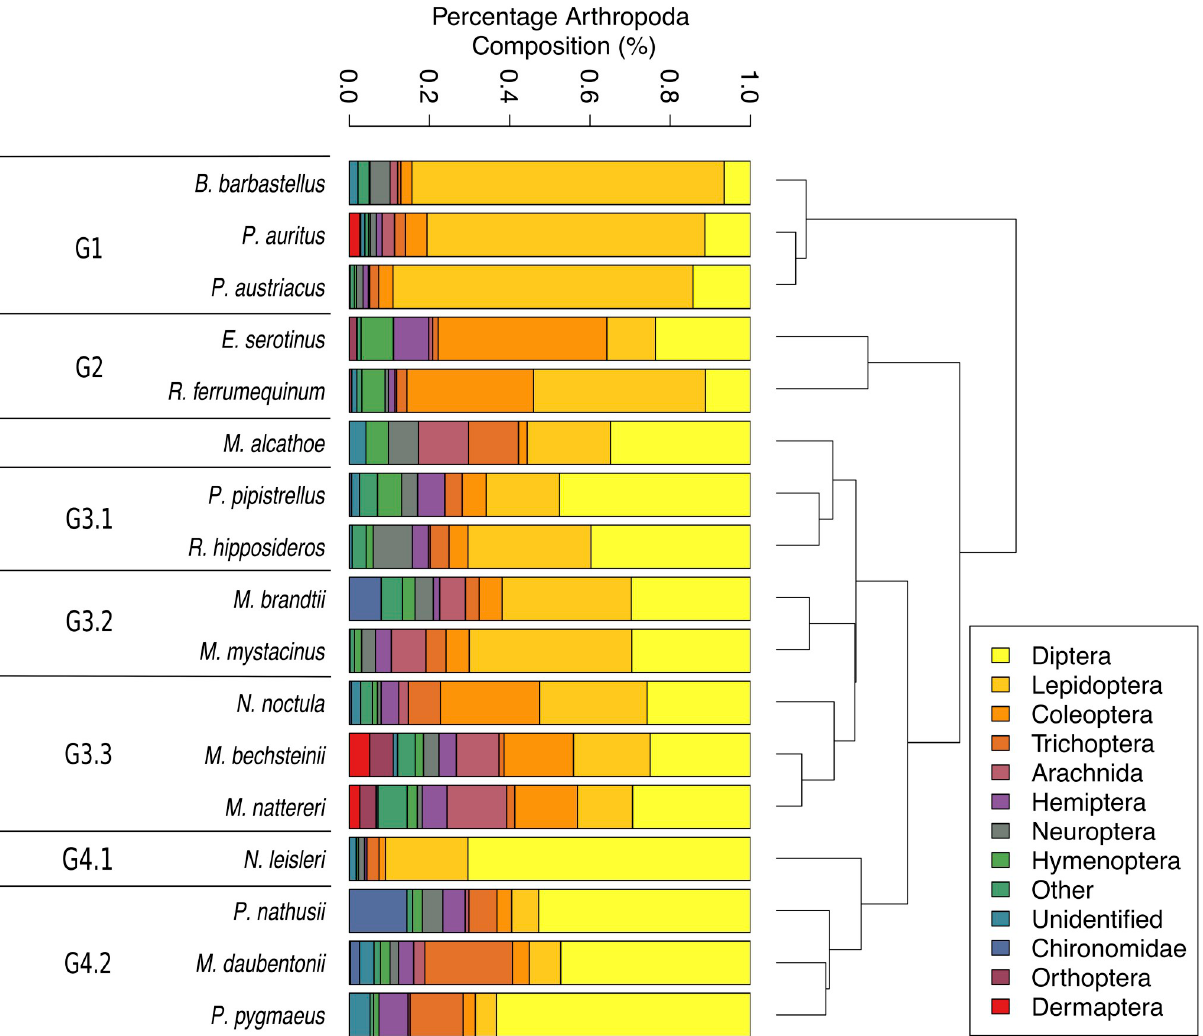
Fig 2. The diet of each bat species as identified from the literature review. The data presented is the mean diet of each of the bat species (for raw data, see S2 Table). Diets sorted using complete-linkage clustering using hclust in